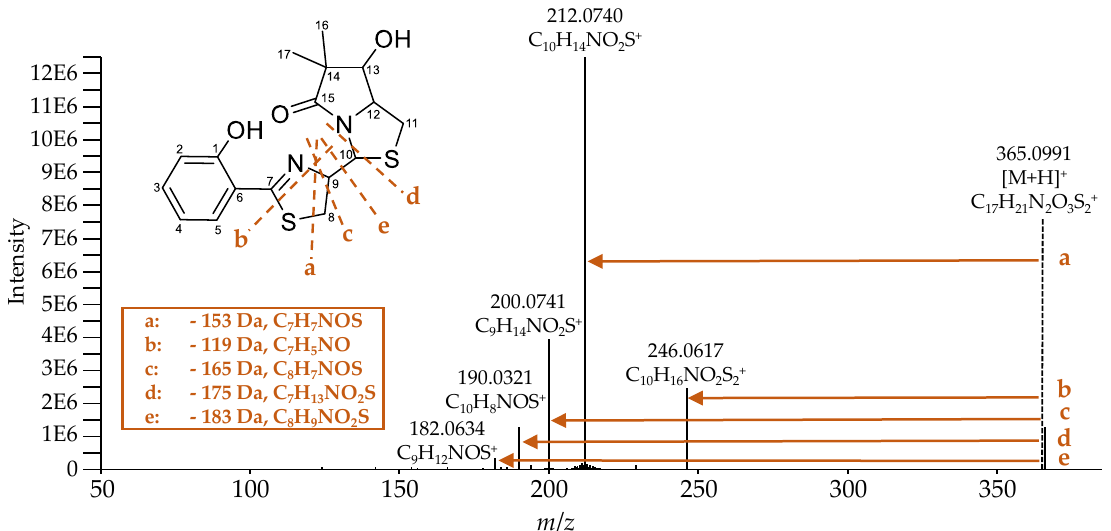
Figure 8. MS 2 spectrum of ulbactin B ([M + H] + : C 17 H 21 N 2 O 3 S 2 + , calculated: m / z 365.0988, measured: m / z 365.0991, ∆ m − 0.8 ppm). It shows an NL of 153 (fragment a), 119 (fragment b), 165 (fragment c), 175 (fragment d), and 183 Da (fragment e), which correspond to the proposed